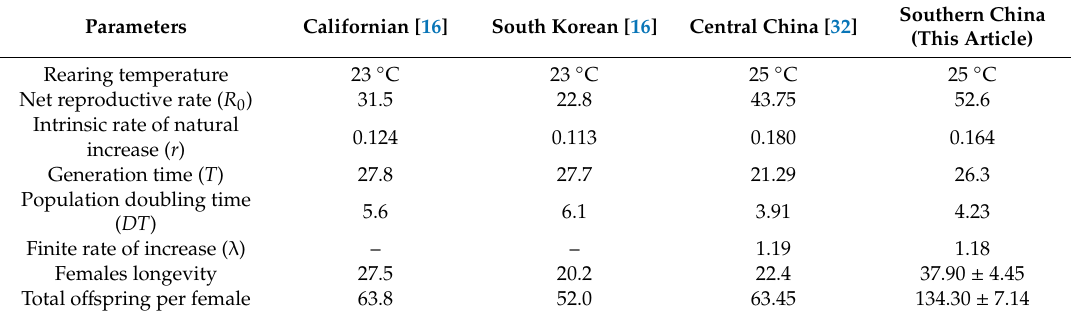
Table 1. Main parameters of population growth of T. drosophilae from di ff erent regional biotypes.